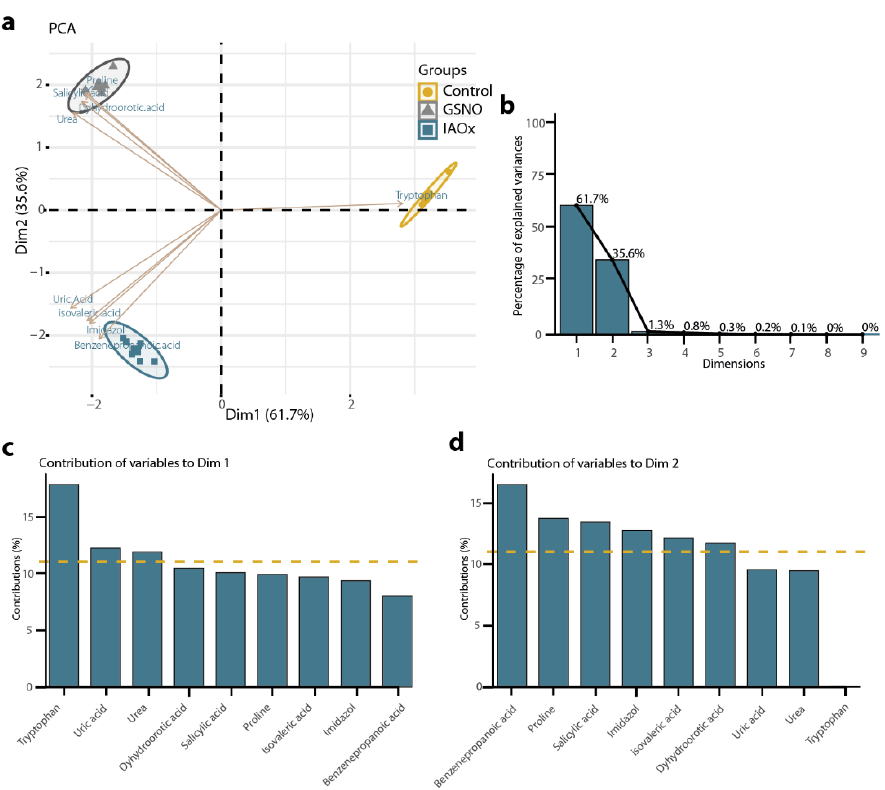
Figure 4. ( a ) The principal component analysis (PCA) using nitrogen-tagged molecules detected in A. thaliana cells by GC-MS as variables (brown). Area group samples of the same treatment, Control (yellow), GSNO (grey), and IAOx (blue). The dot size corresponds to loading cos 2 . ( b ) The relative contribution (%) of each dimension to total variation. The relative contribution (%) of each variable to ( c ) Dim1 (PC1) and ( d ) Dim2 (PC2). The average contribution is delimited by a yellow dashed line.